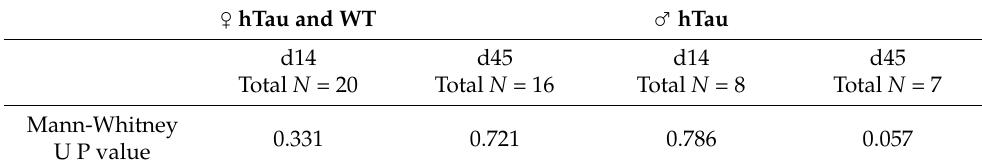
Table A10. Statistical analysis of the ledge test of ataxia and gait instability.